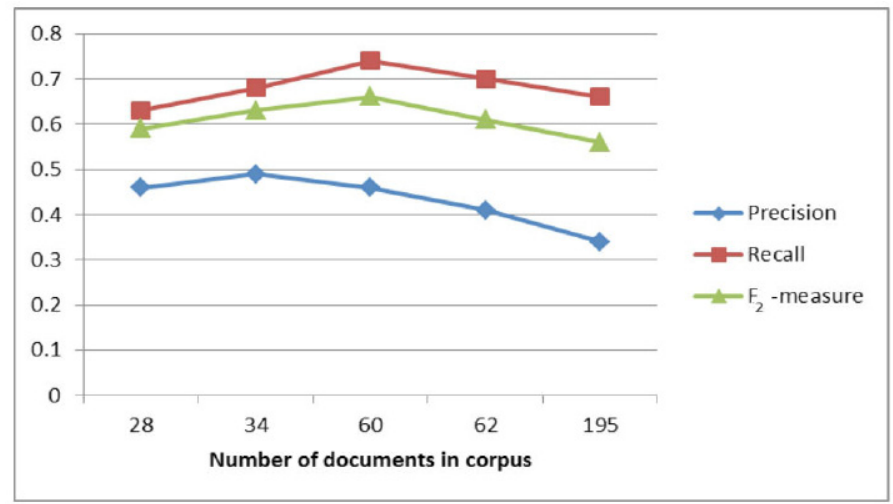
Figure 5. Extraction performance with respect to corpus